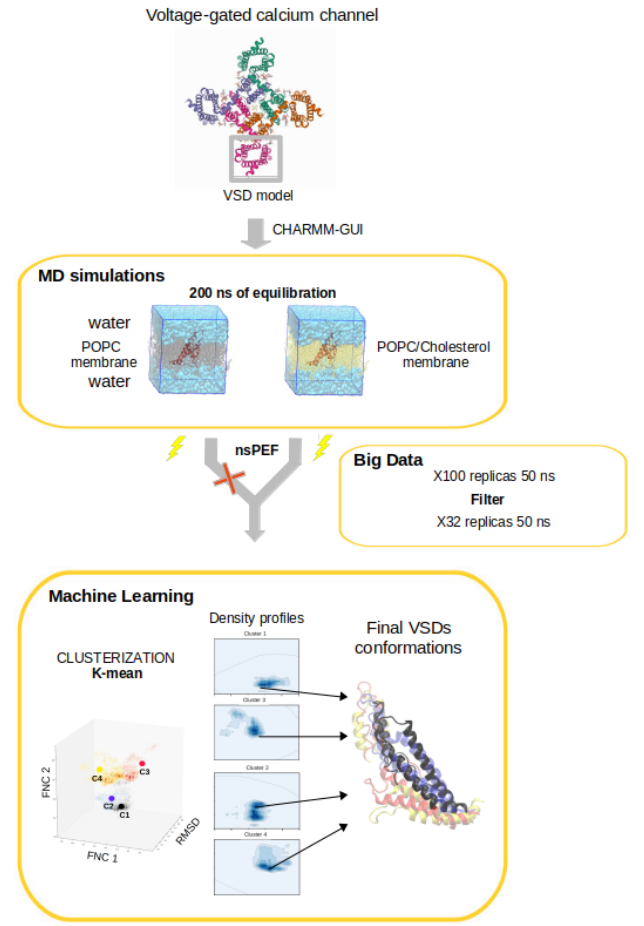
Figure 8. Flowchart of the study depicting the set of steps to determine the effect of the application of a set of external stimuli mimicking nsPEF. After the simulations, a 3D cube of data was produced considering the fraction of native contacts, and the RMSD, both calculated using as reference the initial frame. Once the 3D data cube was produced, an unsupervised K-means clustering was executed, leading to 4 main clusters denoted C1 to C4. From each cluster, the frame with the closest distance (by relying on the least squared method) to the center of mass of each cluster was selected as a representative